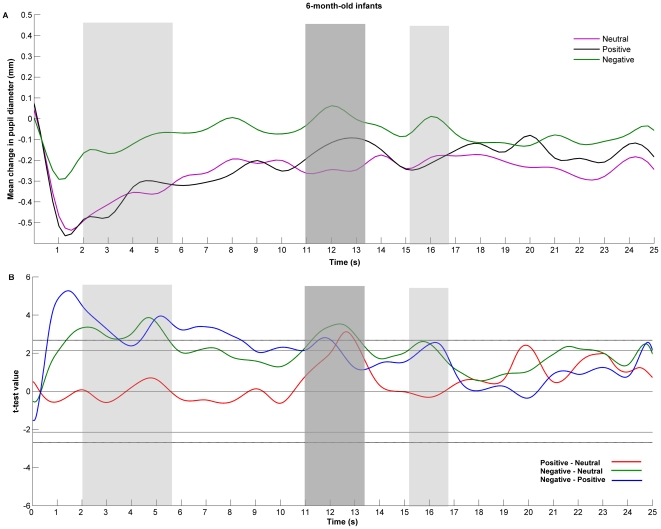
Six-month-old infants' pupil size changes in response to others' affective displays.In Panel A, functional expression of changes in the 6-month-olds baseline corrected pupil size in response to others' neutral (purple line), positive (black line), and negative (green line) emotional displays. Panel B shows the value of t statistic as a function of time for each pair of stimuli comparison: positive vs. neutral (red line), negative vs. neutral (green line), and negative vs. positive (blue line). The one-tailed critical values of t are represented by the vertical lines with (dotted) and without (solid) Bonferroni correction for three comparisons. The difference is considered to be significant when this line is reached or surpassed. Marked with dark gray are those time windows in which both emotional conditions triggered larger pupil diameters than the neutral one, and the hypothesized negativity bias occurred. Marked with light gray are those time windows where negative emotions triggered larger pupil diameter compared to the emotionally neutral state. (Note that the shaded areas are for illustrative purposes only, marking the time window in which the effect occurred and not the effect duration.)